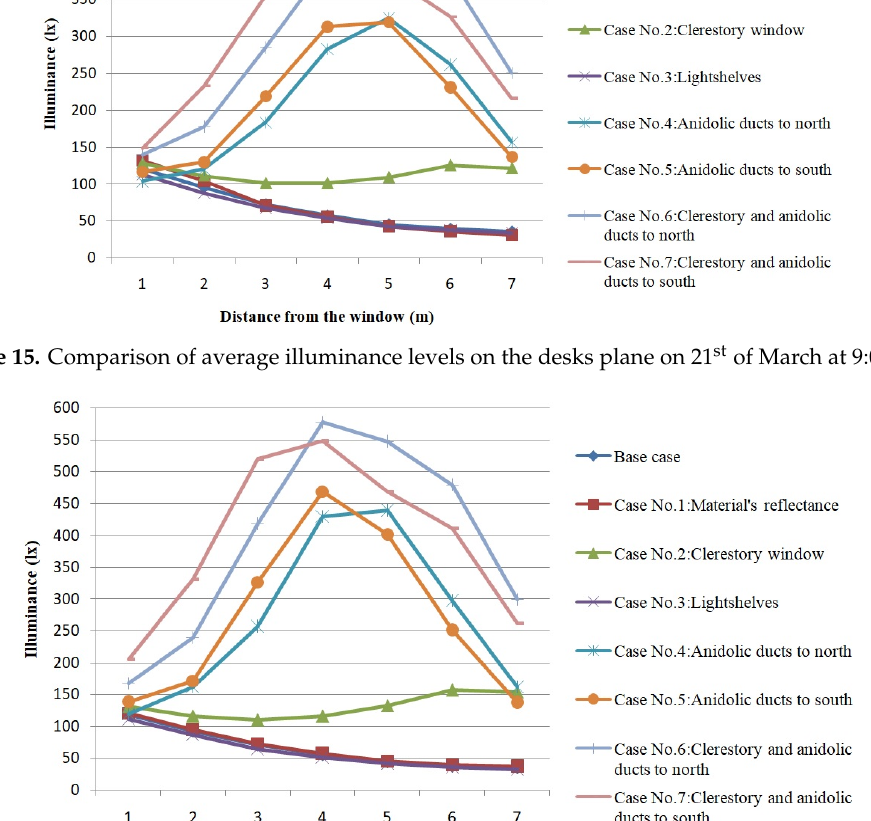
Figure 18. Comparison of average illuminance levels on the desks plane on 21 st of June at 9:00 am. Figure 19. Comparison of average illuminance levels on the desks plane on 21 st of June at 12:00 pm.